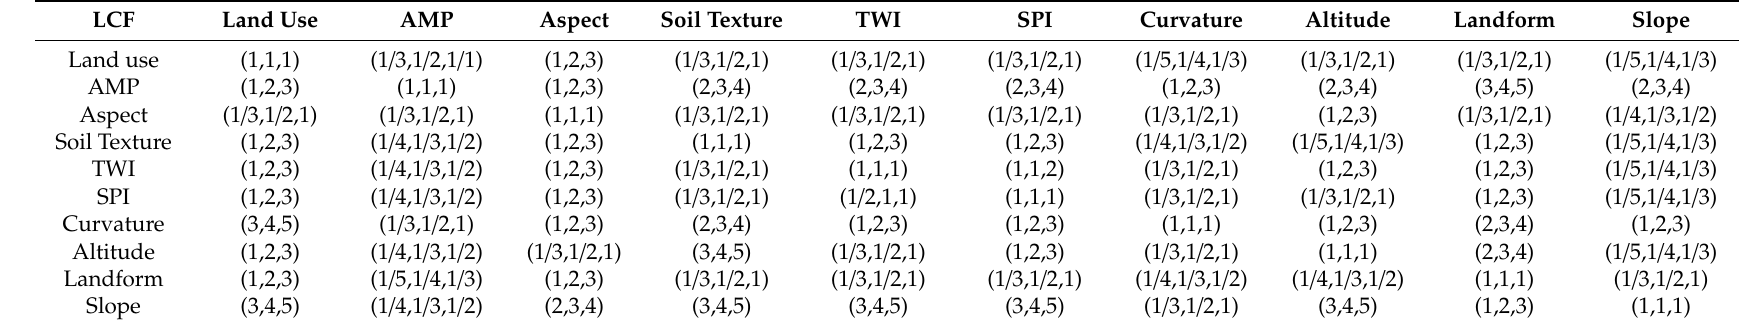
Table 4. Pairwise comparison matrix of the LCFs.